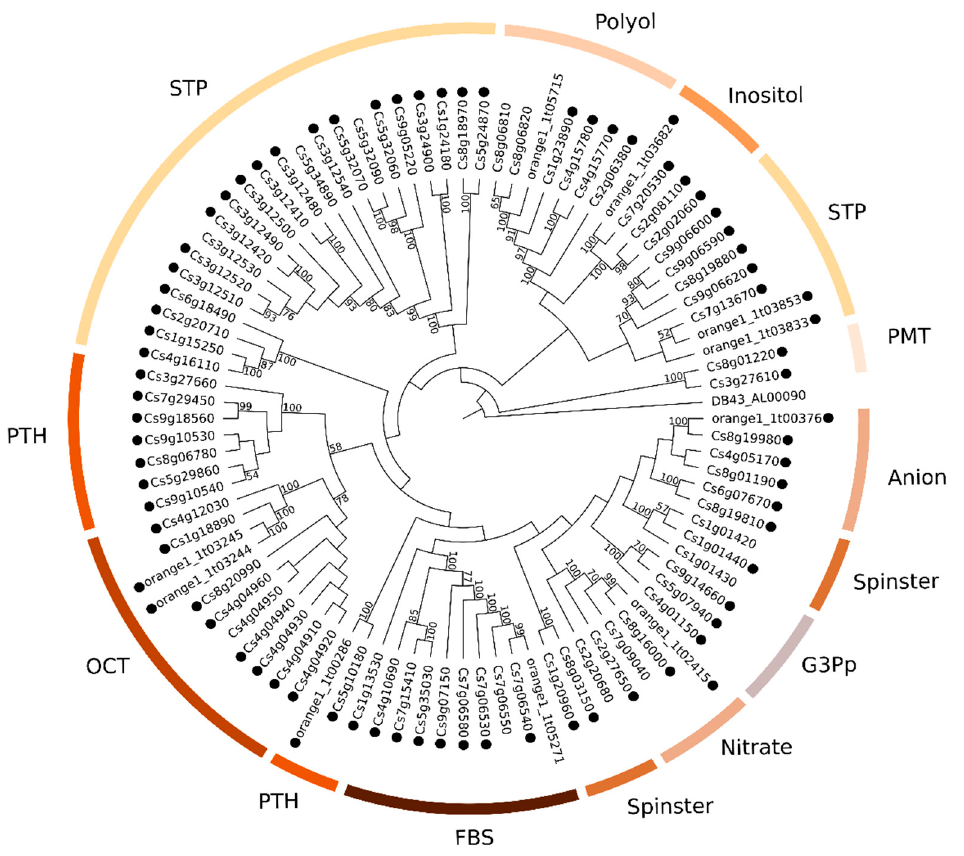
Figure 5. Maximum likelihood tree of 91 MFS amino acid sequences from C. sinensis genome. Numbers above the branches represent bootstrap values. The black circles represent genes that have an associated transcript sequence in the CRT. DB43_AL00090 was used as outgroup (Parachlamydia acanthamoebae, gene ywtG, putative metabolite transport protein YwtG).